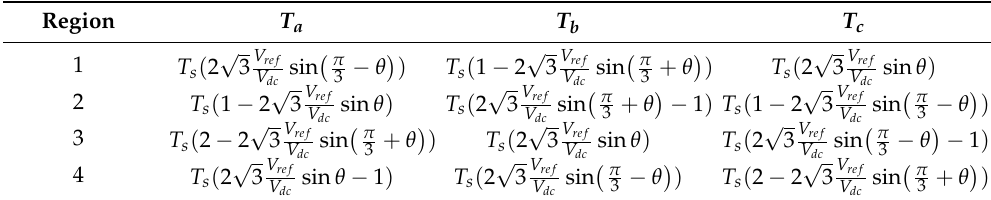
Table 2. Dwell times of the voltage vector according to the regions.